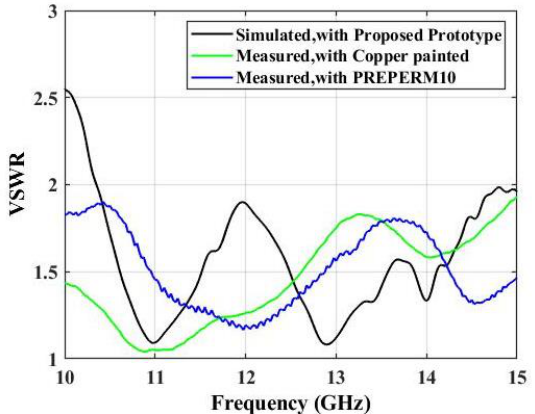
Figure 13. Simulated and measured VSWR